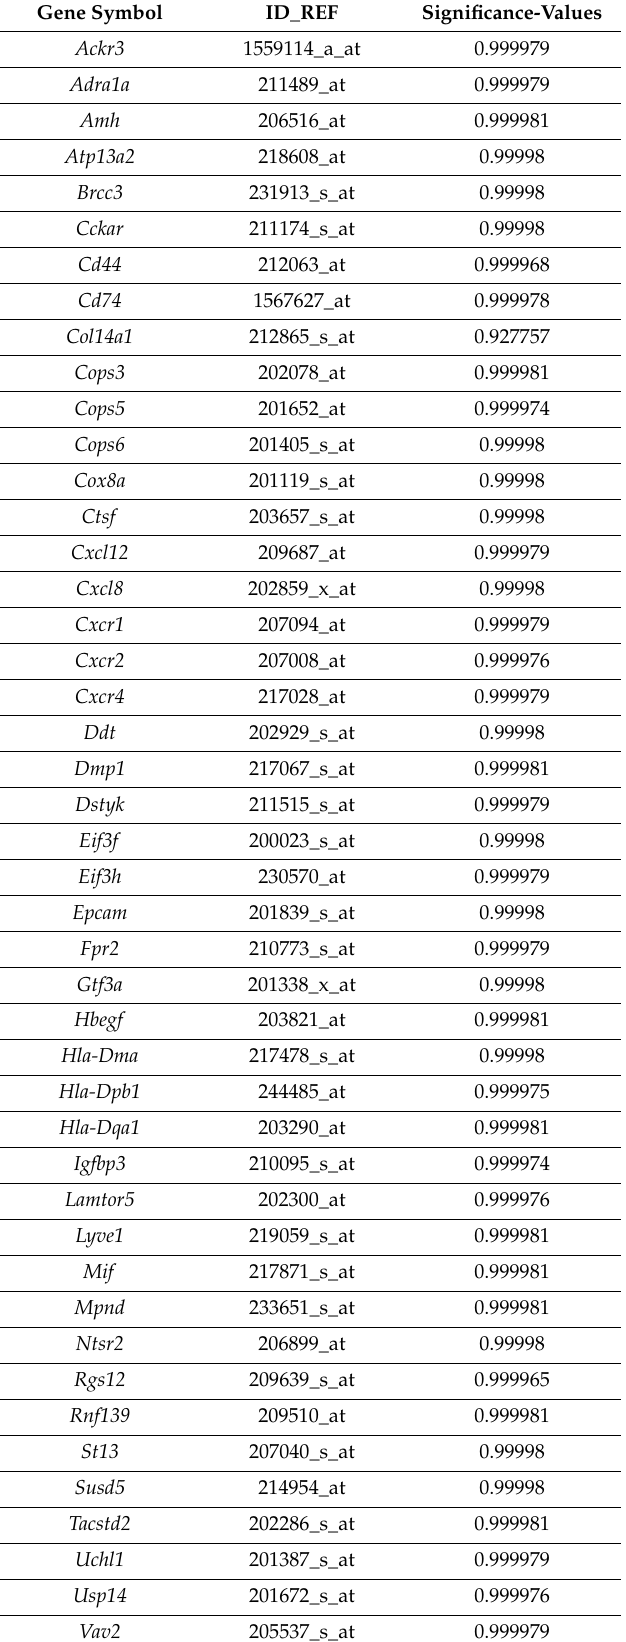
Table 2. Results of the Bayesian estimation of temporal regulation analysis for the MIF-related genes in DMD samples from the GSE38417